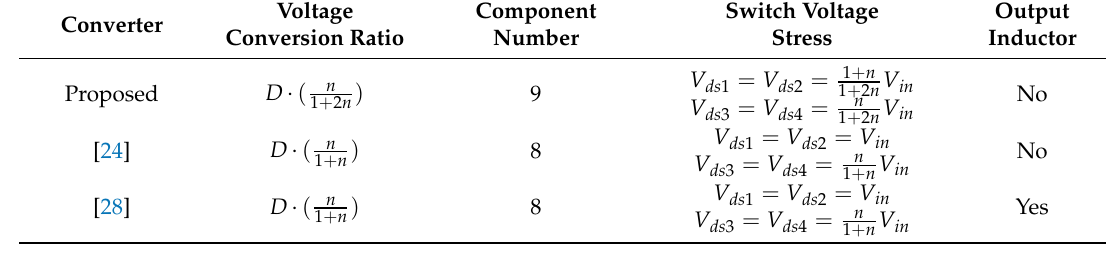
Table 1. Comparison of the proposed circuit with the existing circuits.